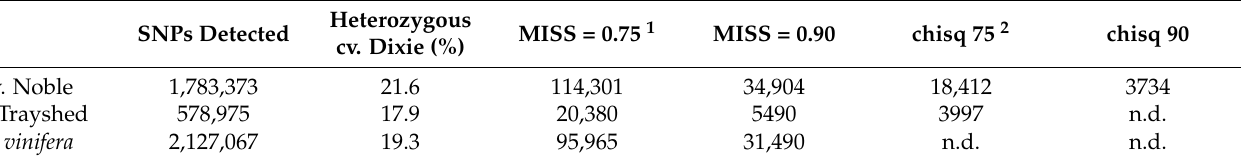
Table 1. Review of SNPs detected in the genome of M. rotundifolia cv. Dixie at different stages of the filtration